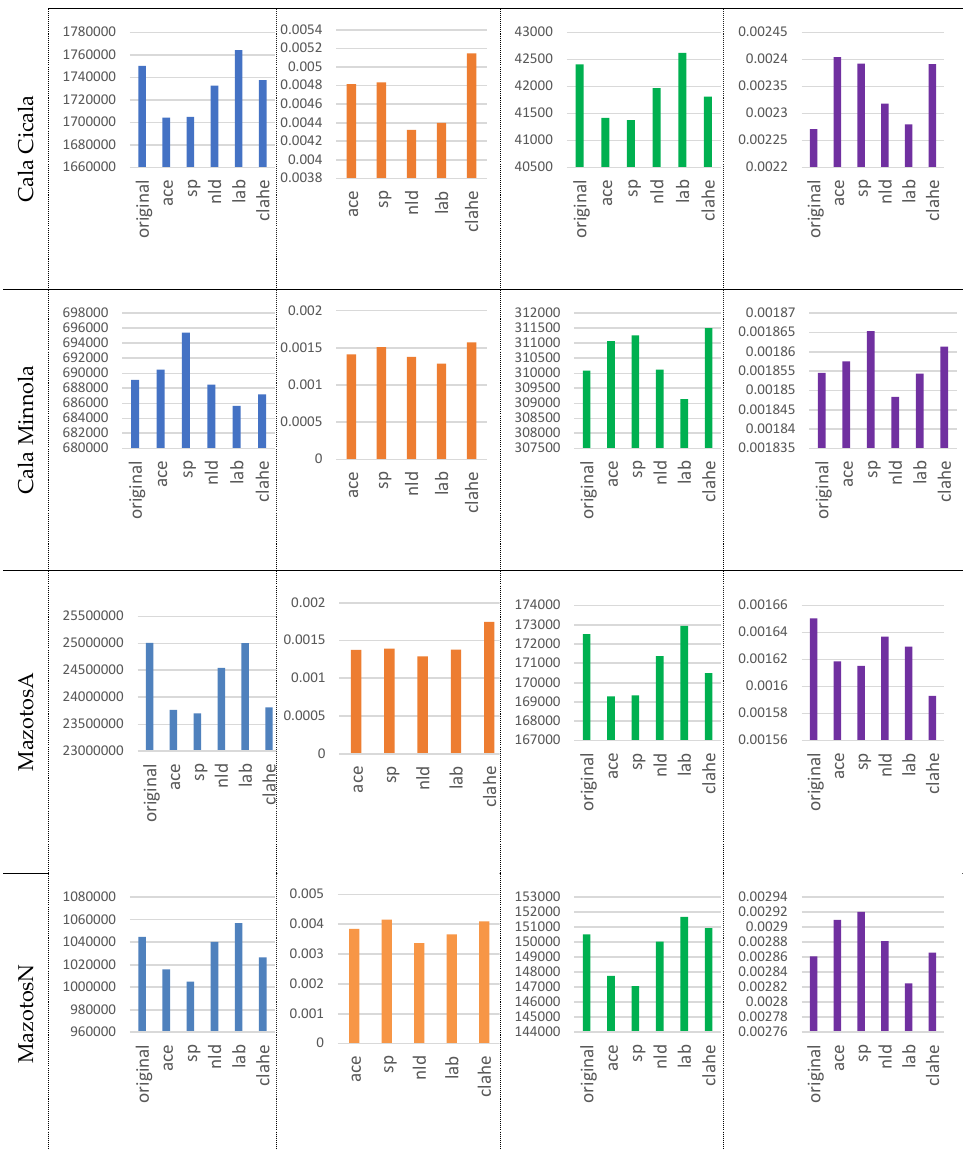
Figure 7. The results of the computed parameters for the five different datasets. To facilitate an overall comparison of the tested algorithms in terms of 3D reconstruction performance and evaluate the numerous results presented above, the surface density D and roughness R metrics were normalized and combined into one overall metric, named as the Combined 3D metric ( C3Dm ). To achieve that, the score of every image enhancement algorithm on D and R was normalized to the score of the 3D reconstruction computed using the original images. Hence, the 100% score is referred to the original 3D reconstruction. If an image enhancement algorithm has a negative impact on the 3D reconstruction, then the score should be less than 100% and if it has a positive impact, the score should be more than 100%. For both surface density D and roughness R , the same weight was used.